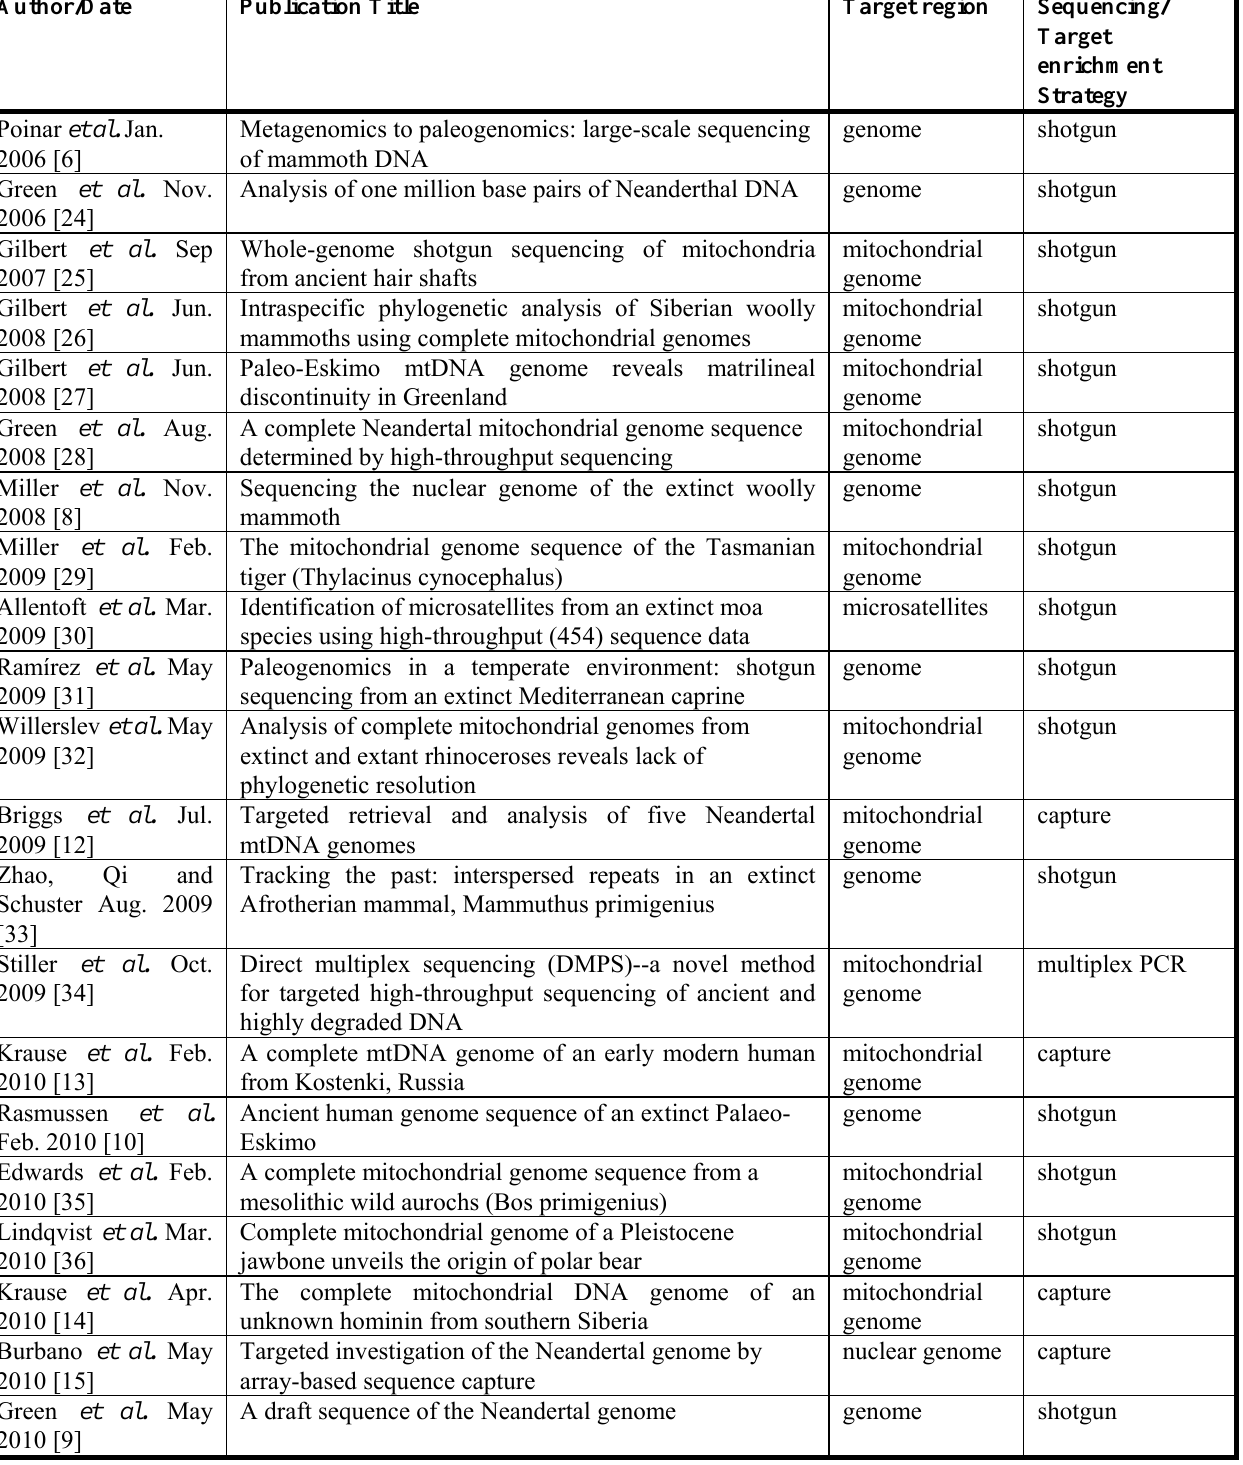
Table 1. Ancient DNA studies using next generation sequencing partly or exclusively for sequence data